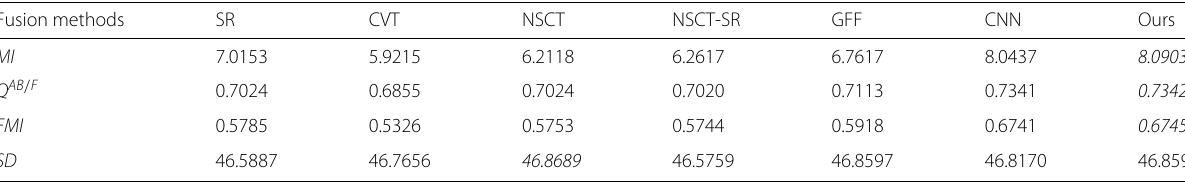
Table 1 Objective contrast of “Disk” Fusion